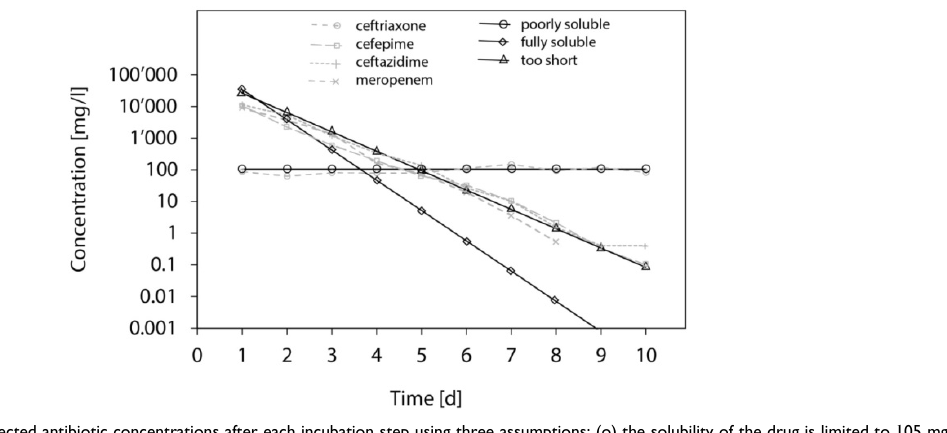
Figure 5. Calculation of the expected antibiotic concentrations after each incubation step using three assumptions: (o) the solubility of the drug is limited to 105 mg/L (e.g. Ceftriaxone); ( Δ ) the drug is fully soluble and the system is fully equilibrated at the end of each incubation; ( □ ) the drug is fully soluble, but only 85% of the drug have time to diffuse out of the pellets at the end of each incubation. To assess the validity of these calculations, some of the experimental results are plotted: (o) Ceftriaxone; (x) Cefepime; ( ▲ ) ceftazidime; (+)